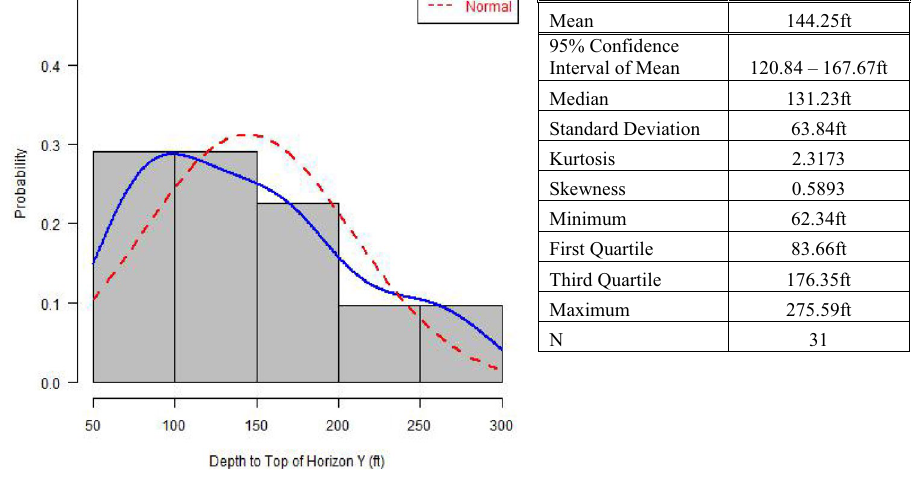
and distributions of depths to top of Horizon Y